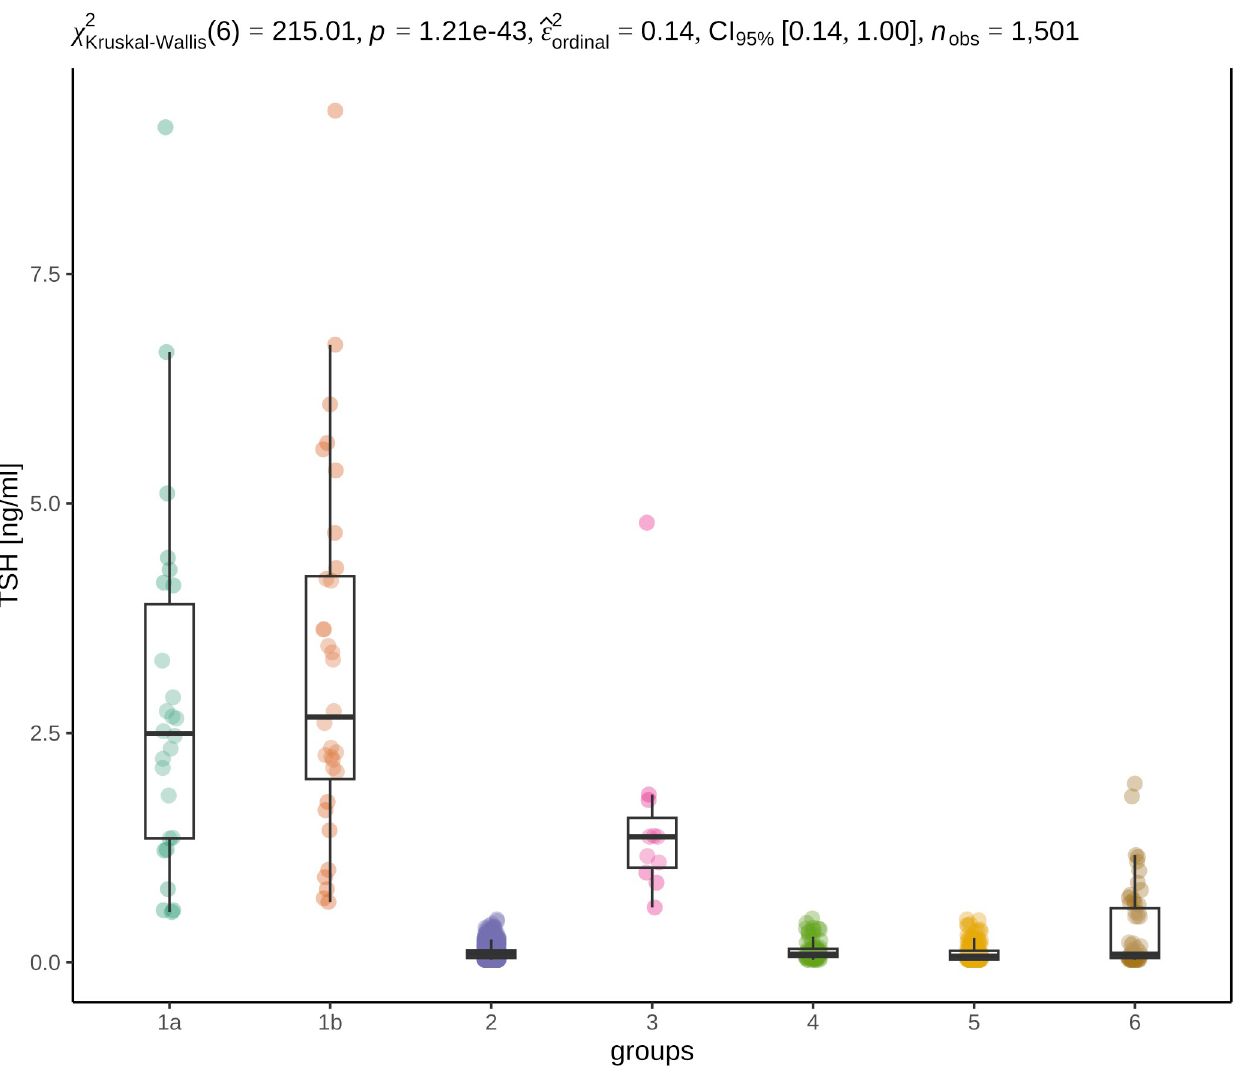
Fig 5. Box and dot plots show the distribution of TSH concentrations in the different groups. TgAA-positive hypothyroidism (group 1a), TgAA- negative hypothyroidism (group 1b), euthyroidism (group 2), subclinical hypothyroidism (group 3), TgAA-positive dogs with unremarkable thyroid function (group 4), potential nonthyroidal illness (group 5), unclassified dogs (group 6). The groups are displayed on the x-axis, and the y-axis shows the TSH concentrations of the dogs in ng/ml. The p value of 1.21e-43 (p < 0.001) (in the first line of the graphic) provides very strong evidence that at least one of the groups differs from the others [45]. Partial epsilon squared ( ^ ε ^2 ) with a 95% CI as the measure of the effect size for Kruskal–Wallis test is 0.14, ordinal indicating that the effect of the groups on the distribution of TSH concentrations is large [45]. P values were determined by Dunn pairwise tests. A significant difference in the distribution of TSH concentrations was observed in groups 1a, 1b and 3 compared with all the other groups (p < 0.001 in all cases), but not among each other, and between groups 5 and 2/4/6 (p � 0.01). dogs. Of those, 42.5% (17/40) developed hypothyroidism (Table 4): 66.7% with subclinical hypothyroidism (4/6), 31% with TgAA-positivity and an unremarkable thyroid function (9/ 29), and 80% with an initially positive TgAA status in group 6 (not classified, 4/5). Sensitivity, specificity, positive predictive value (PPV) and negative predictive value (NPV) of TgAA to predict the presence of hypothyroidism were 44.8%, 93.6%, 22.0% and 97.7%, respectively. Sensitivity, specificity, PPV and NPV of TgAA to predict development of hypothyroidism at a later time were 65.4%, 92.3%, 42.5% and 96.8%, respectively.